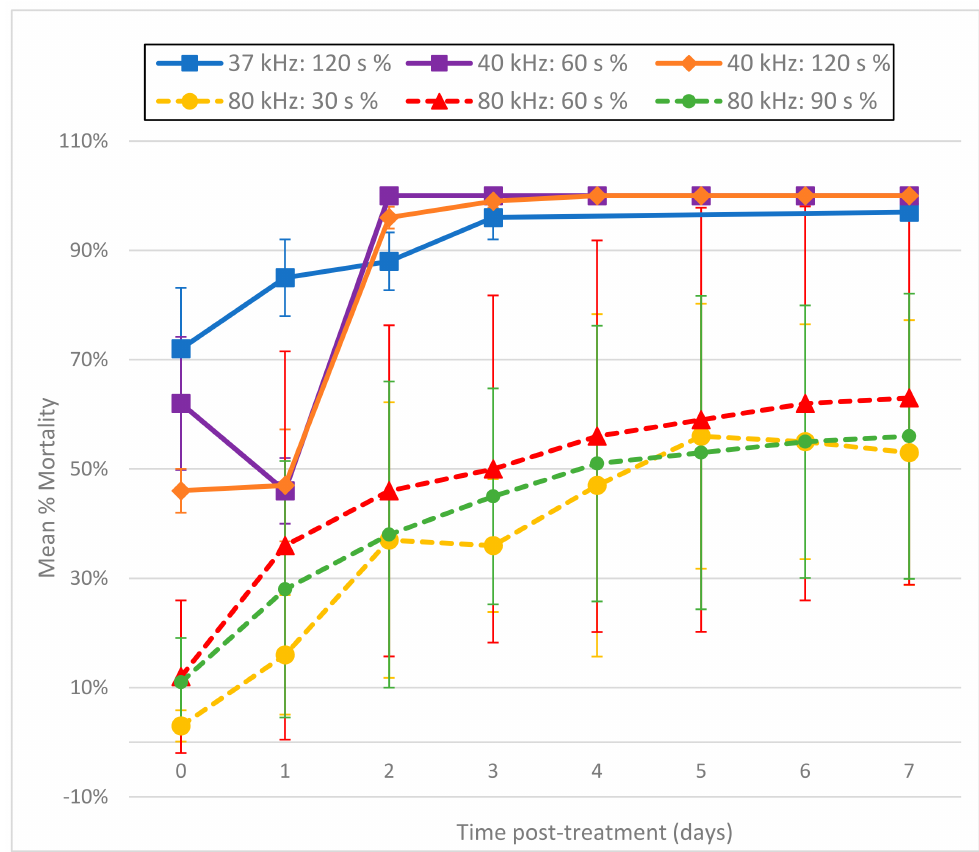
Figure 4. Mean percentage mortality from exposing A. cantonensis larvae to Branson 1510R-MT (40 kHz) and Fisherbrand FB-11201 (37 and 80 kHz) ultrasonic cleaners in triplicate. Percentage mortality was normalized by estimating the total number of dead L3 (number of dissolved L3 plus the number of fluorescent L3), and then dividing by the original total number of L3.